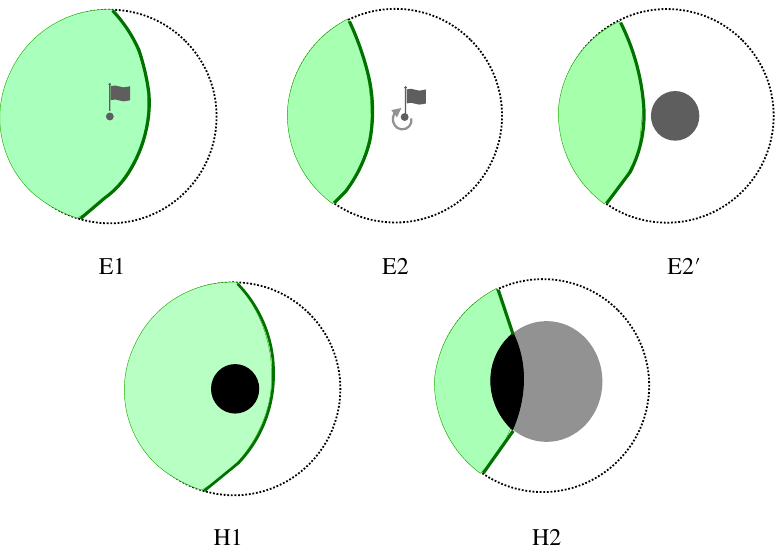
Figure 3 . The different types of space-time slice described in the main text. The actual slice is colored in green, the complementary region is excised. The letters ‘E’ and ‘H’ stand for ‘empty’ and ‘horizon’, and the grey flag denotes the rest point of an inertial observer. Note that since this is excised in E2, a conical singularity in its place is permitted. The centerful slice E1 can act as a gravitational Faraday